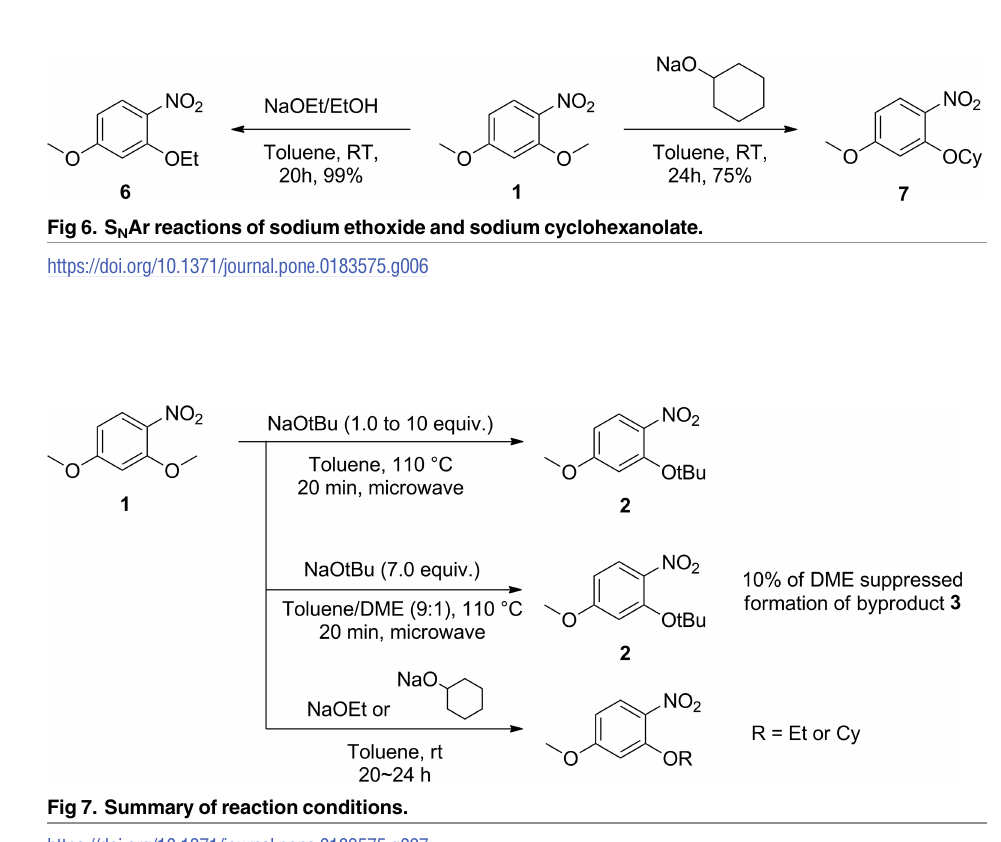
Fig 5. Proposed mechanism for the formation of 2 and 3.